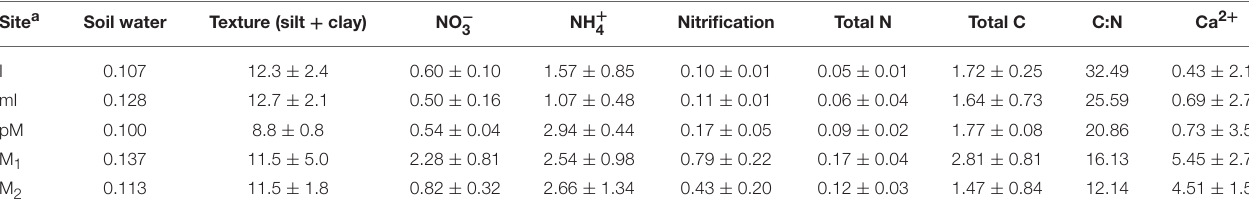
TABLE 2 | Mean soil fertility attributes for forest sites where soil was collected for the plant-soil feedback greenhouse experiment. Site